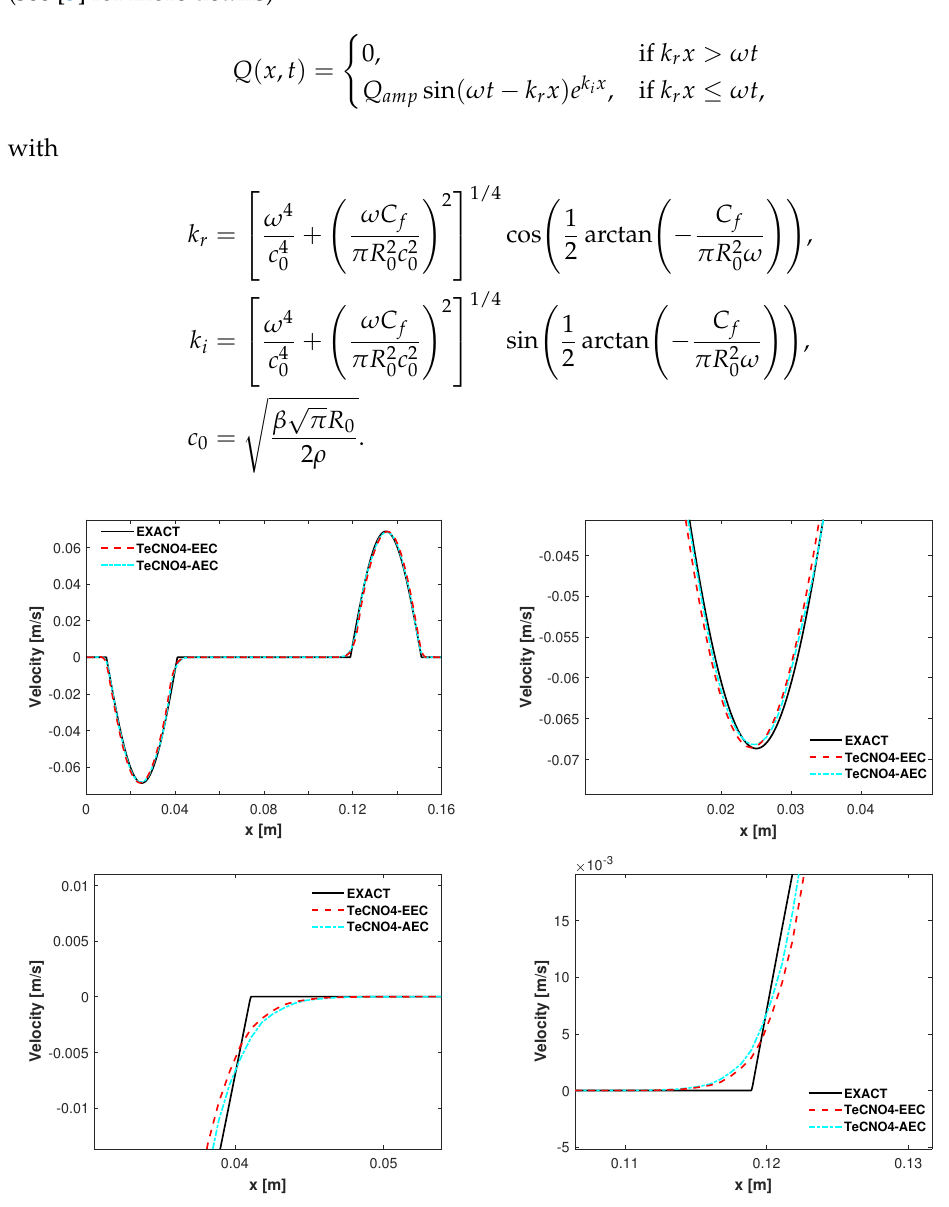
Figure 3. Example-2: Numerical solutions (for velocity) of the wave equation at t = 0.004 s on a mesh with 200 cells with enlarged views in selected